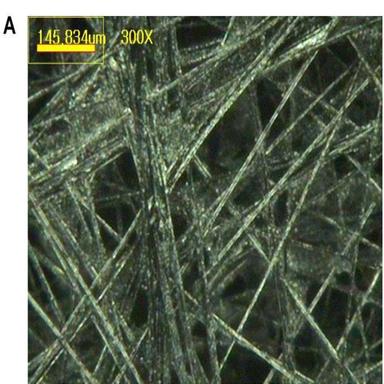
(a) A scanning electron microscope image of a commercial gas diffusion layer and (b) a stochastically computer-generated microstructure of porous transport layers with a 5 wt% PTFE loading.